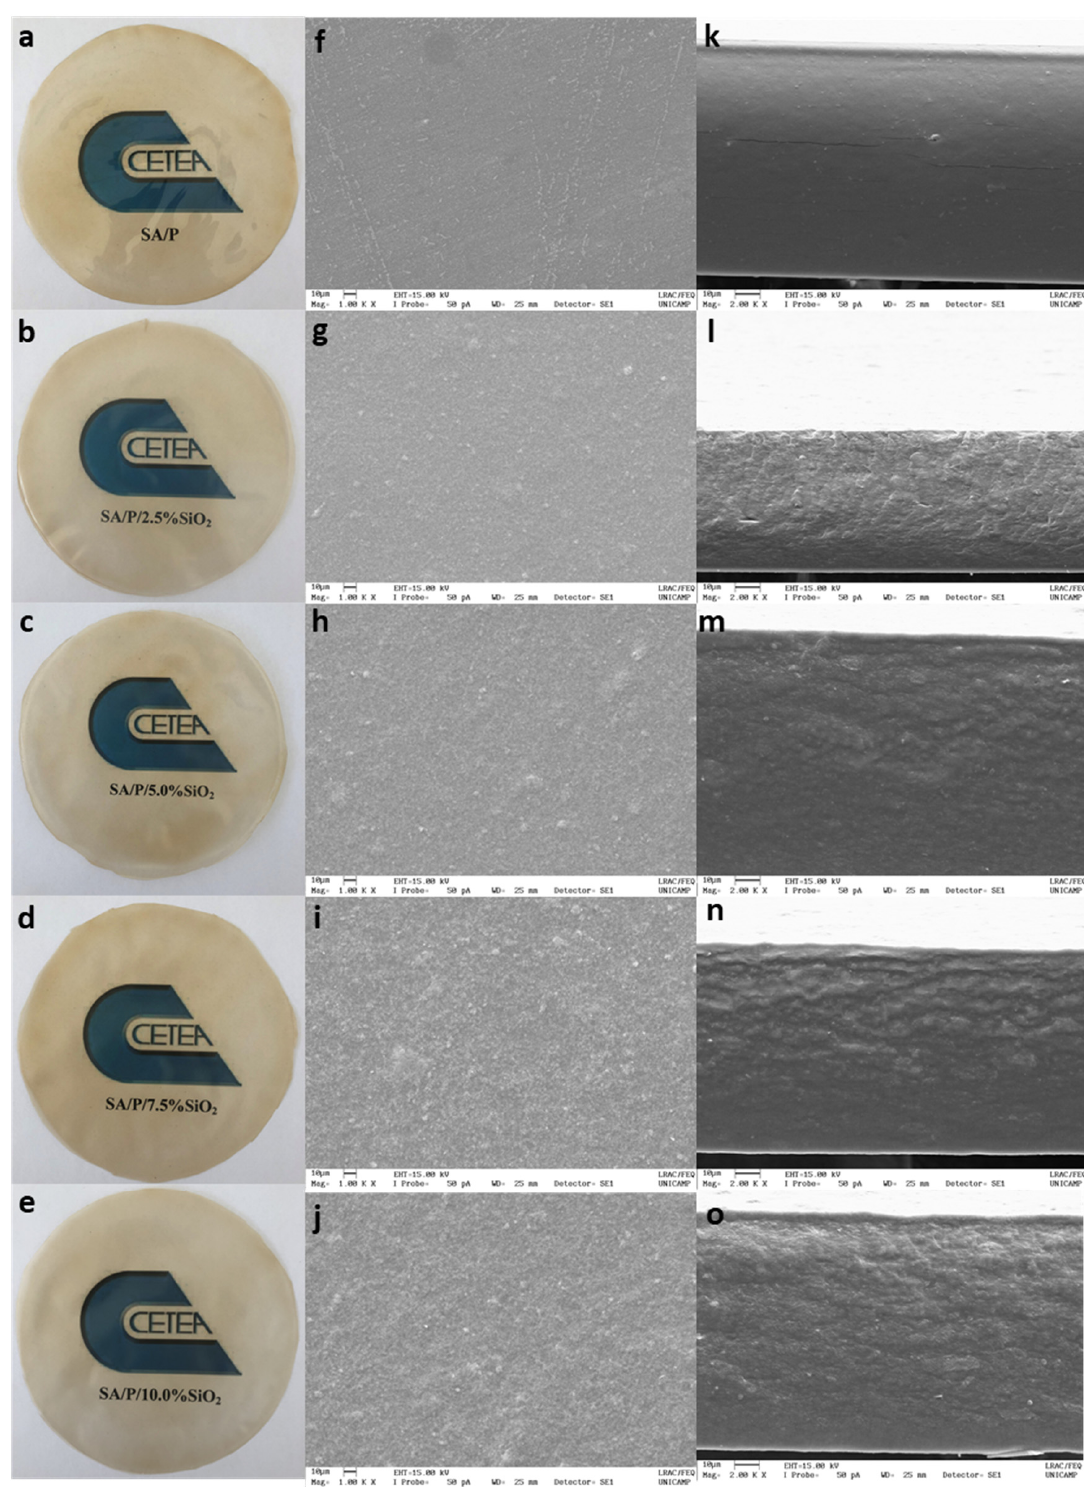
Figure 1. Photographs and SEM micrographs of the surface and cross-section of SA/P ( a , f , k ), SA/P/2.5%SiO 2 ( b , g , l ), SA/P/5.0%SiO 2 ( c , h , m ), SA/P/7.5%SiO 2 ( d , i , n ), and SA/P/10.0%SiO 2 ( e , j , o ) films.